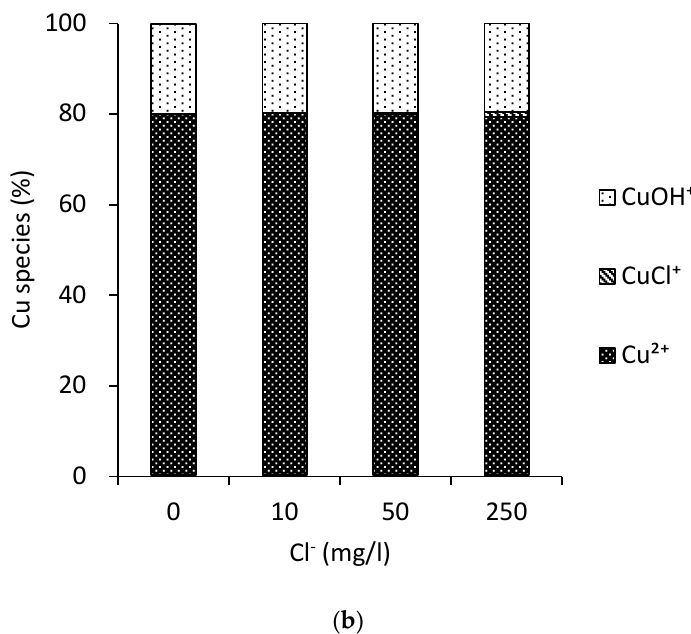
Figure 3. Effects of chloride ion on ( a ) silver species and silver ion release from silver embedded ceramic cubes; ( b ) copper species and copper ion release from copper embedded ceramic cubes.